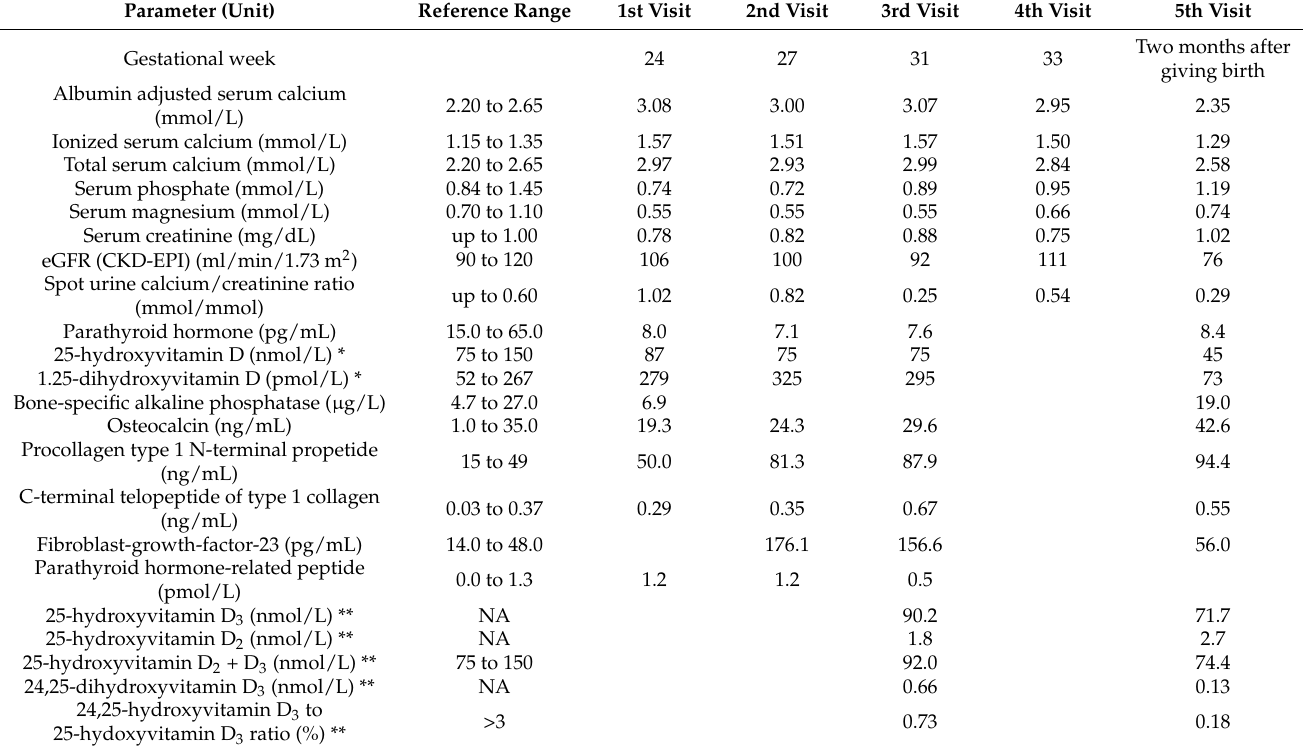
Table 1. Selected characteristics of the case patient with pathogenic CYP24A1 mutations at the endocrine outpatient